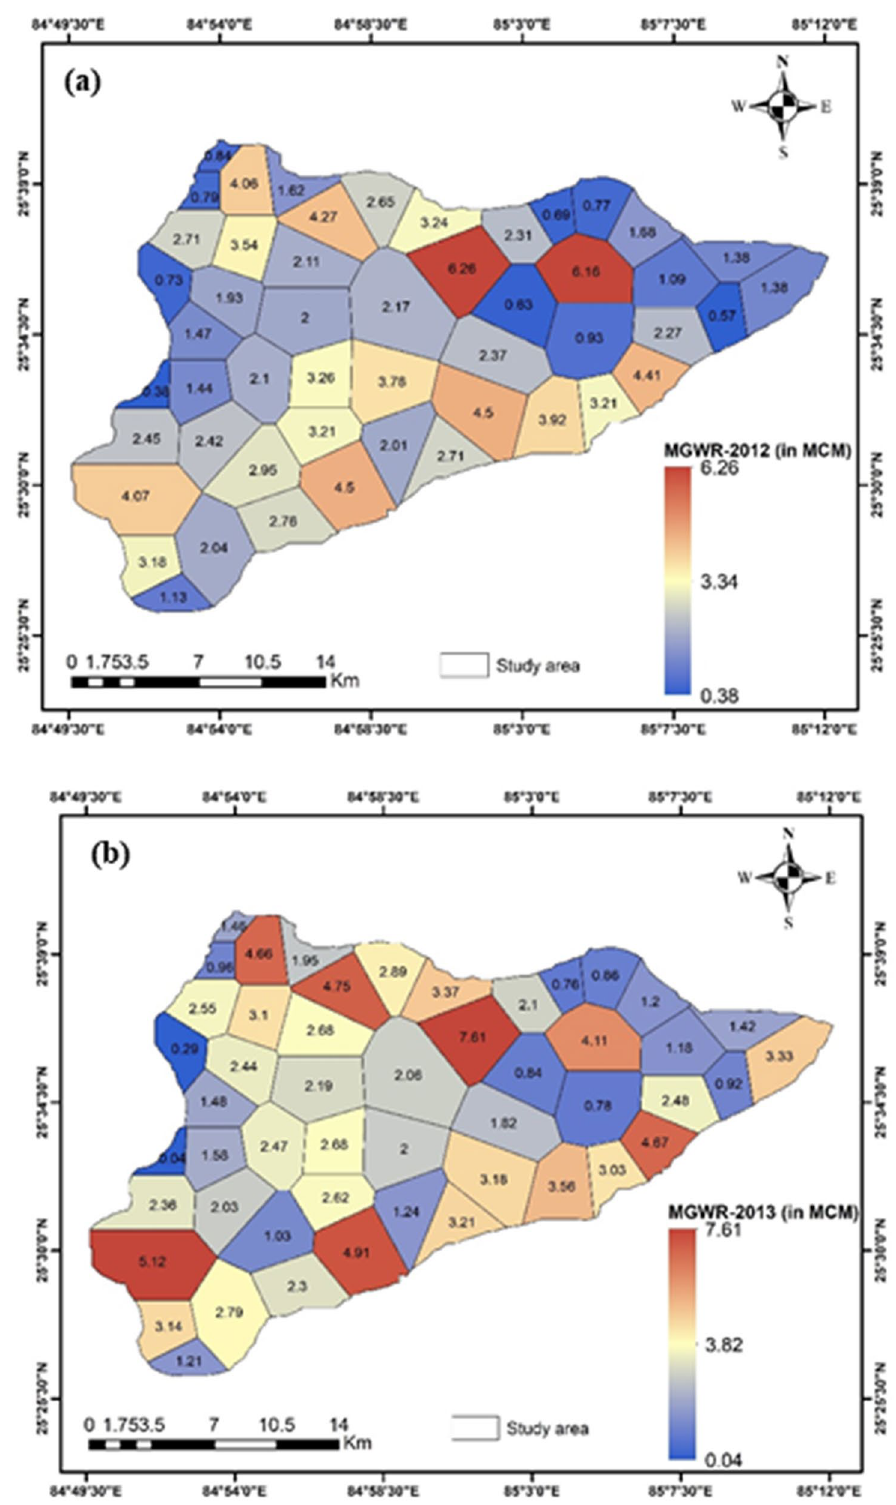
Figure 4. Thiessen polygons and the estimated monsoon groundwater reserve (in MCM) at each polygon in a part of the Ganga basin of Northern India for the year of ( a ) 2012, and ( b) 2013 (V.A.: drawn this figure using the Thiessen polygon tool in ArcGIS ver.10.4, http:// www. esri.